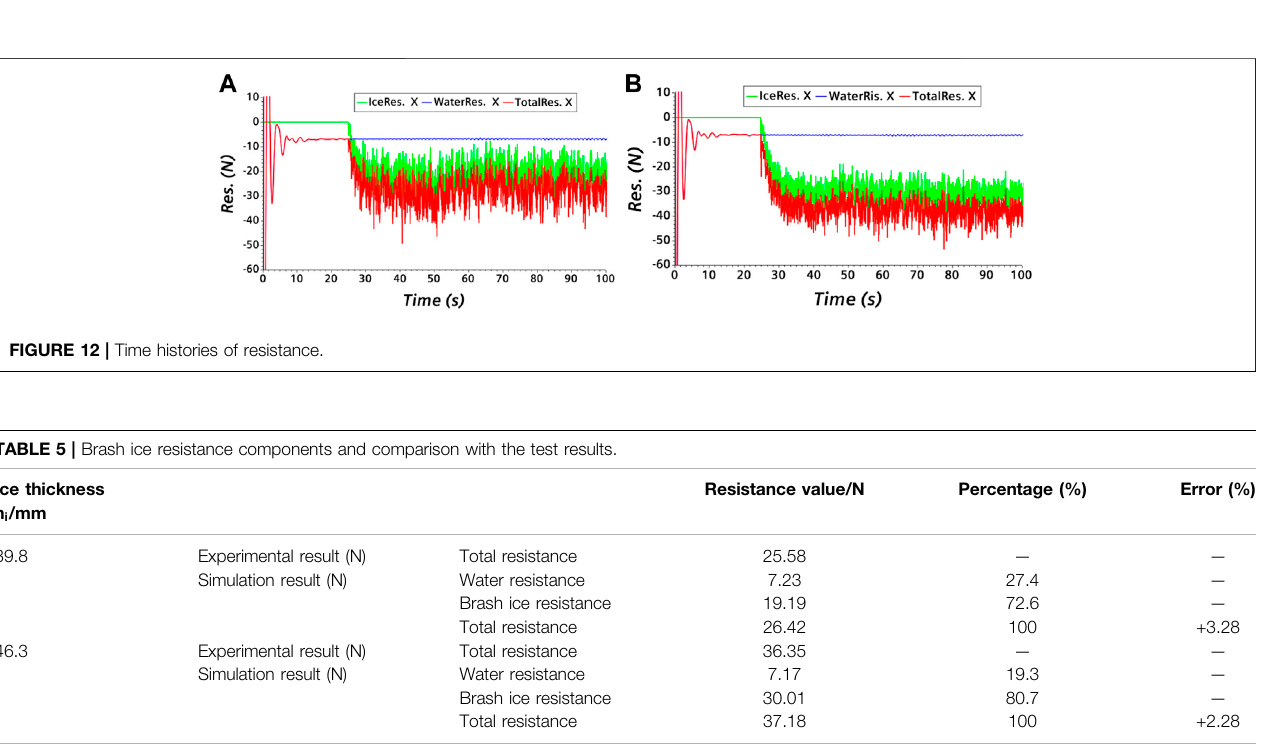
Figure 4A . The boundary layer mesh adopted a prism layer mesh, and the volume mesh adopted the trimmed mesh. Meshes were re fi ned on the hull surface, bow and stern, and free surface. To